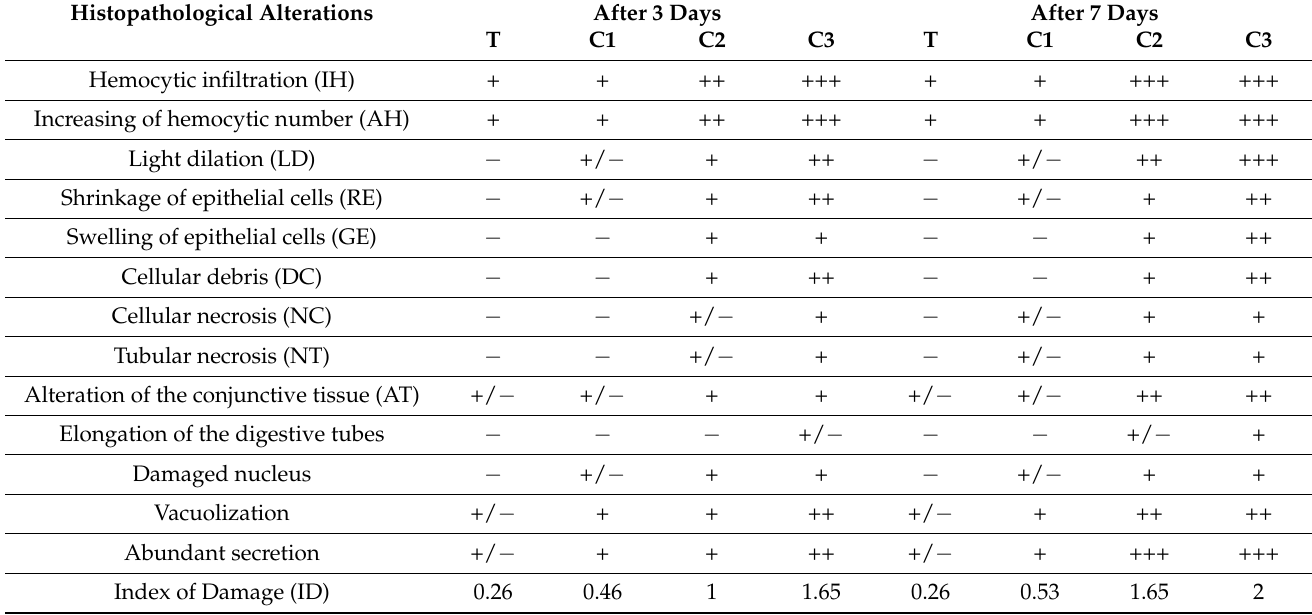
Table 2. Intensity of histopathological alterations at digestive glands of Ruditapes decussatus exposed to triclosan (C1, C2, and C3) for 3 and 7 days. Incidence of lesions: ( − ) absent, (+/ − ) sometimes, (+) frequent, (++) very frequent, (+++) always present. Ut: untreated; C1: 100 ng/L; C2: 200 ng/L; C3: 500